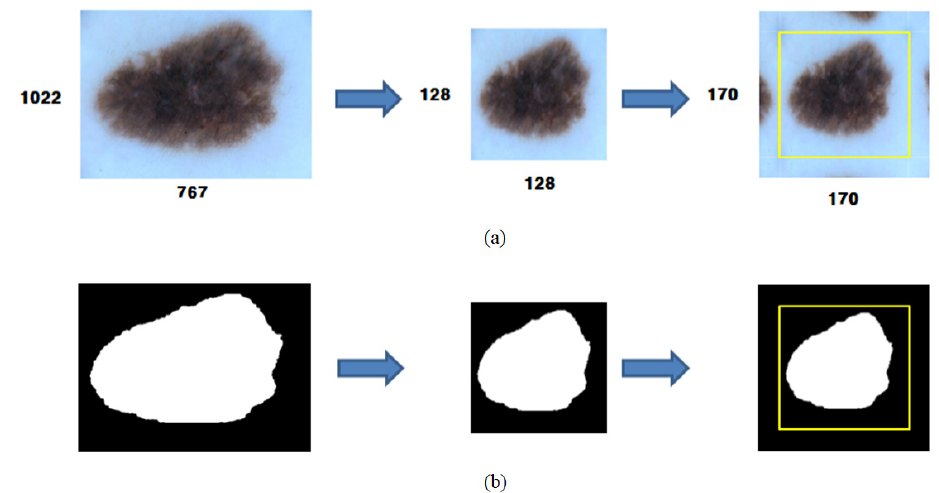
Figure 4. Examples of cases of applying ( a ) symmetric padding and ( b ) zero padding.